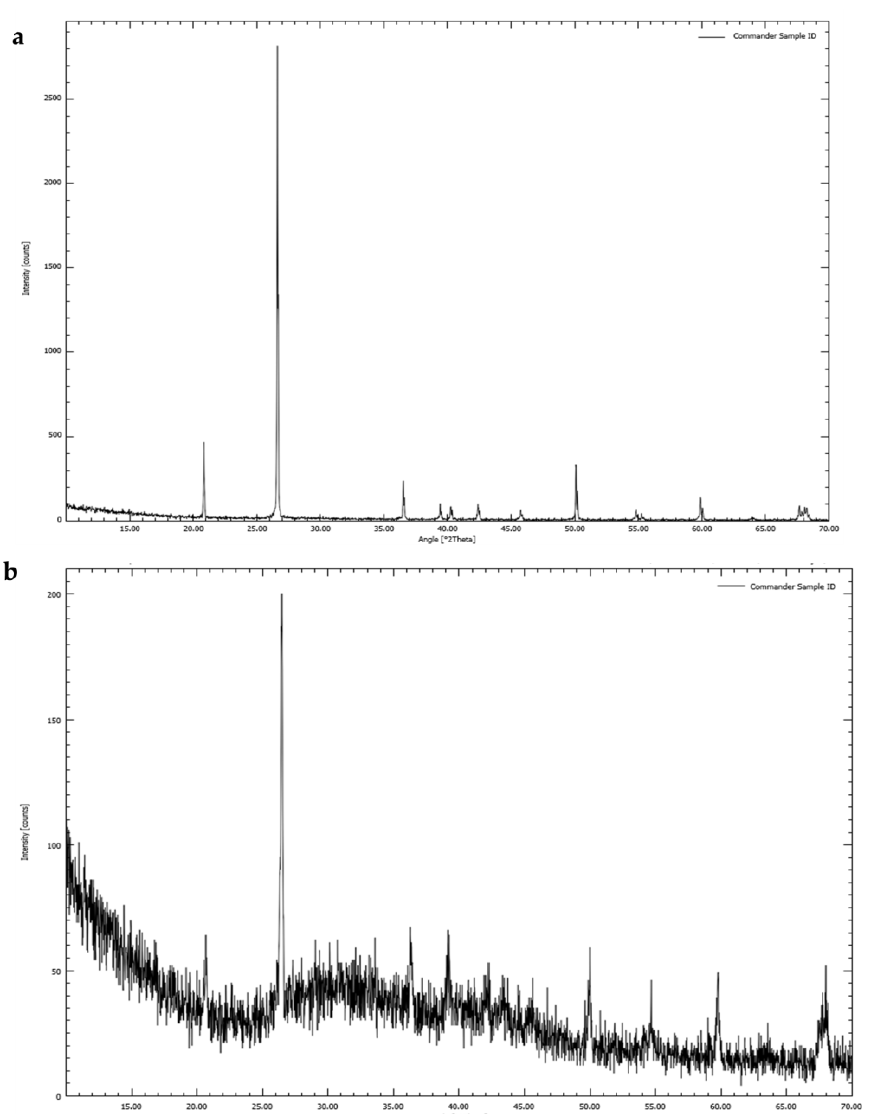
Figure 1. XRD of ( a ) feldspar (catalyst support) and ( b ) 20% Li-TiO 2 /feldspar.